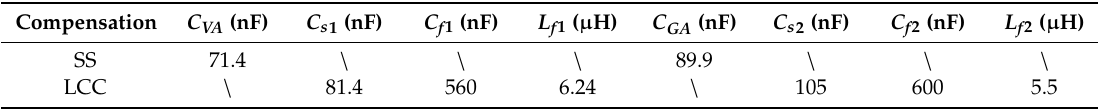
Table 3. Compensation capacitors and inductors.